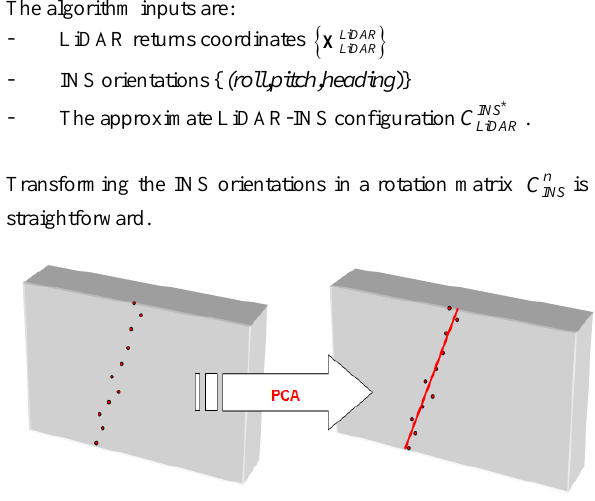
Figure 4 : Scanning line